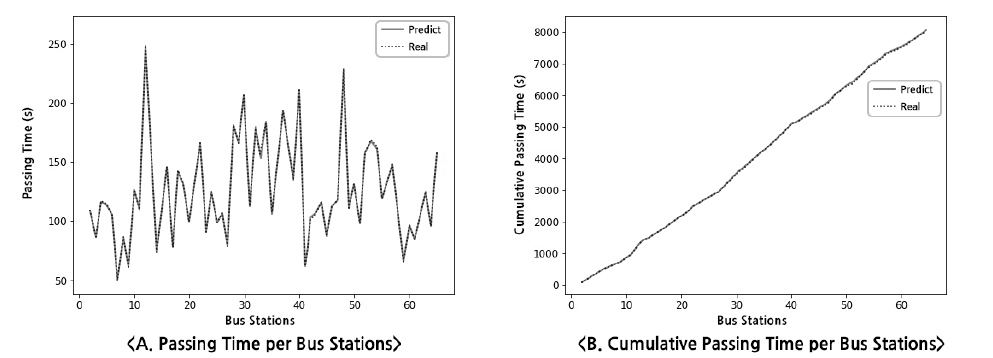
Figure 6. Passing times and cumulative passing time of a bus at each bus station.